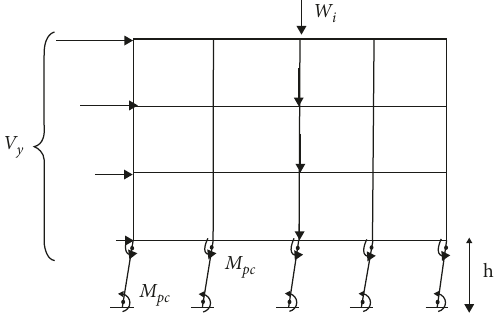
Figure 5: Soft-story failure